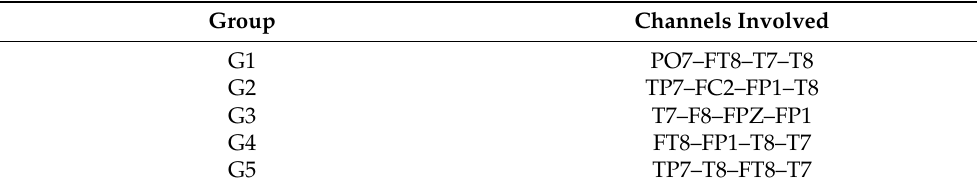
Table 2. Groups of channels.